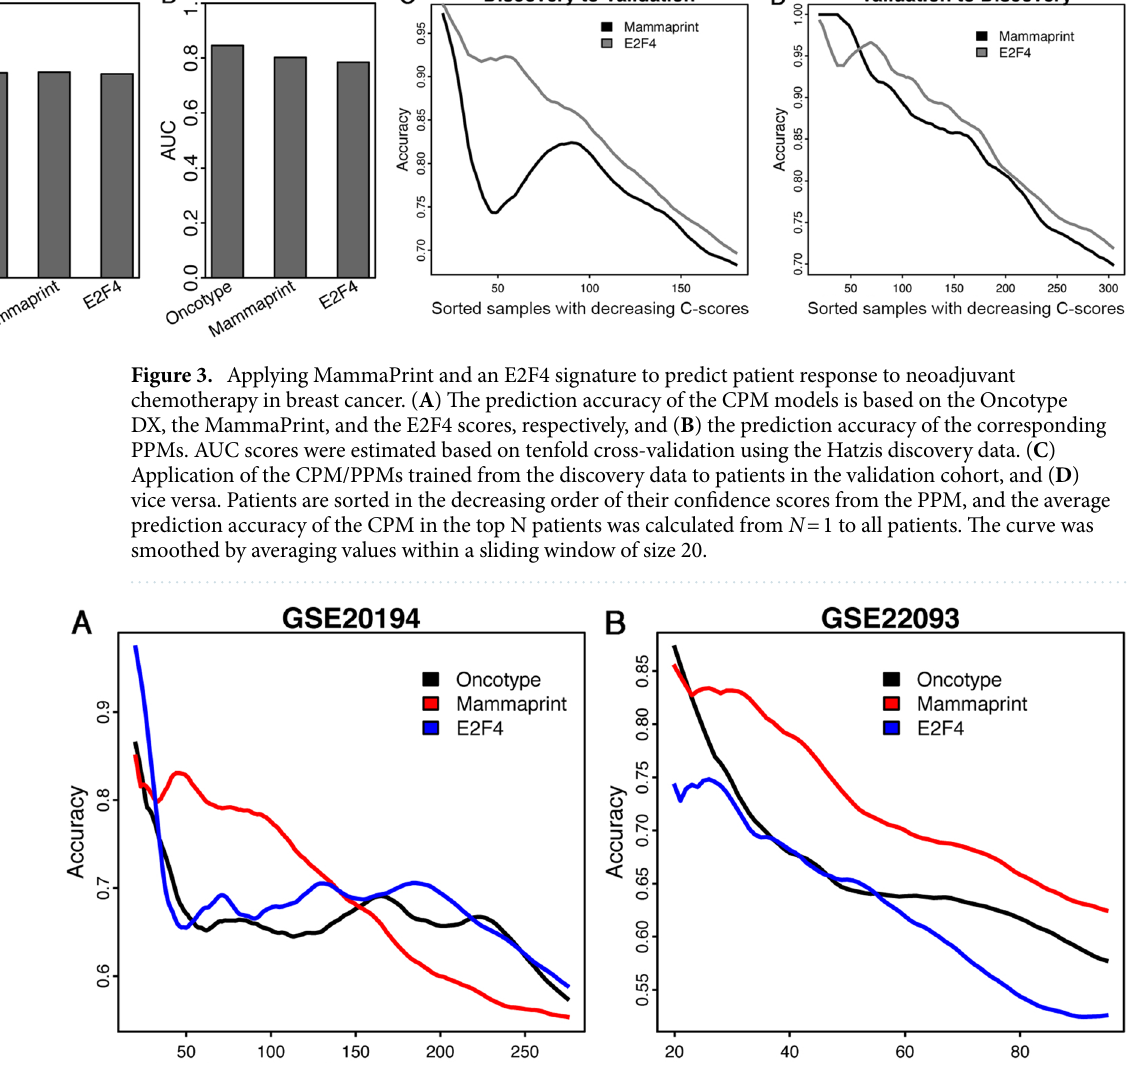
Figure 4. Applying the CPM/PPMs trained from the Hatzis data to two independent neoadjuvant breast cancer datasets, ( A ) GSE20194 and ( B ) GSE22093. For each patient a prognostic score ( P -score) and a confidence score (C-score) were predicted by the CPM and the PPM, respectively. Patients were sorted in the decreasing order of their C-scores, and the average prediction accuracy of the CPM in the top N patients was calculated from N = 1 to all patients. The curve was smoothed by averaging values within a sliding window of size